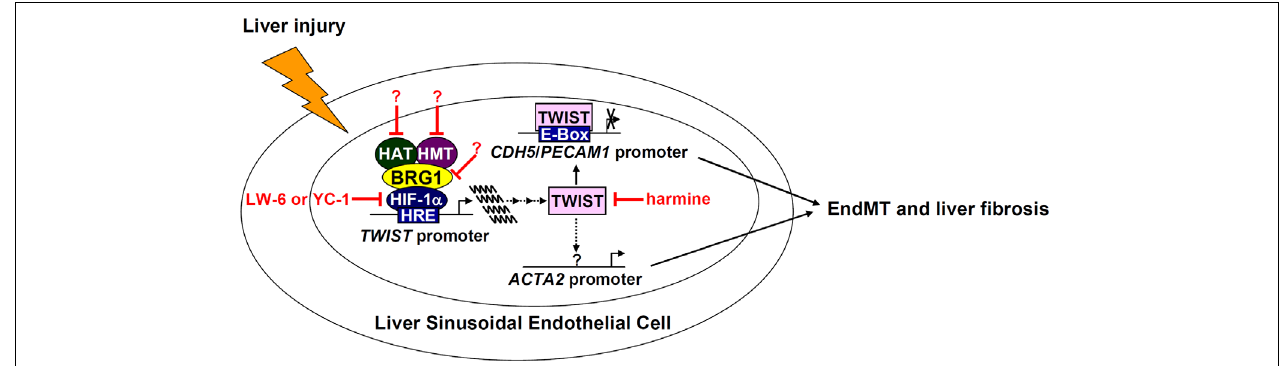
FIGURE 7 | A schematic model. In response to liver injuries, liver sinusoidal endothelial cells undergo EndMT contributing to myofibroblast activation and liver fibrosis. Specifically, HIF-1 α recruits BRG1, which in turn recruits histone modifying enzymes (histone acetyltransferase, HAT, and histone methyltransferase, HMT), to the TWIST promoter to activate TWIST transcription. TWIST represses endothelial gene expression and activates mesenchymal gene expression to promote EndMT and liver fibrosis. Pharmaceutical targeting of various factors involved in the proposed model, some of which (harmine for instance) have been tested in this paper, will hopefully provide novel interventional strategies against liver